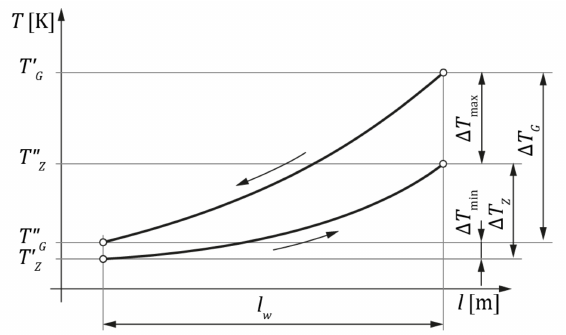
Figure 6. Temperature as the function of fluid flux distance in an anticurrent heat exchanger under adiabatic conditions, where l w is the length of the heat exchanger; T (cid:48) (inlet) of hot and cold fluid fluxes, respectively; and T (cid:48)(cid:48)